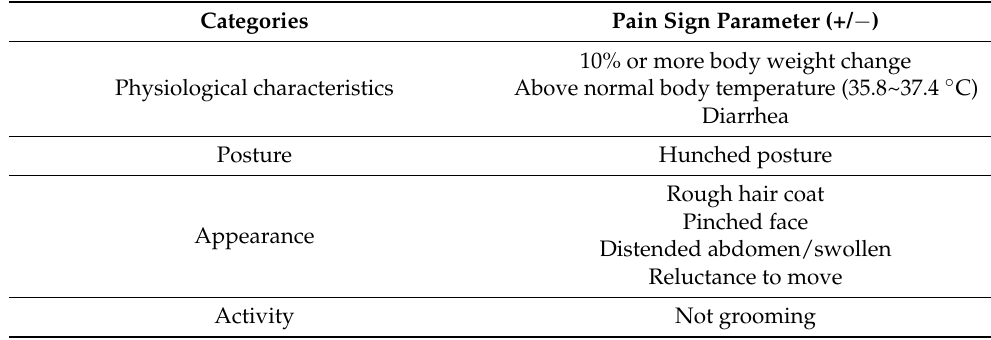
Table 2. Categories used to calculate